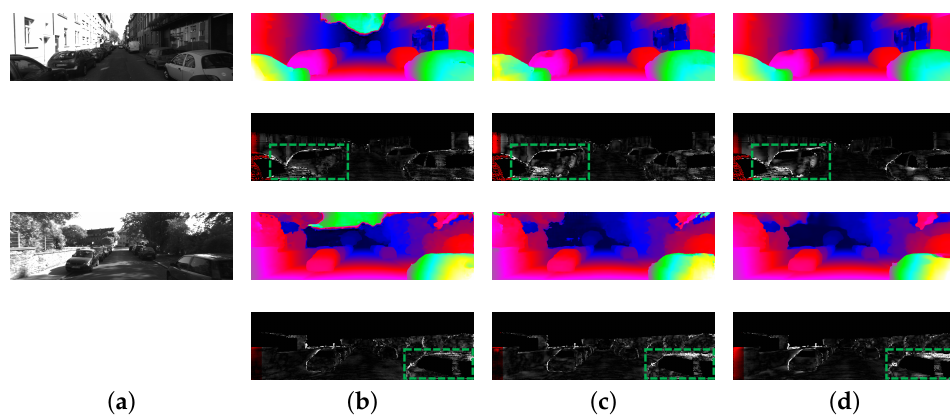
Figure 4. Results of disparity estimation for KITTI 2012 test images. We select the classic 3D stereo method PSMNet and recent proposed fast method AANet for comparison. We use the standard color scheme to represent the error and disparity maps. ( a ) Left Image. ( b ) JDCNet. ( c ) PSMNet. ( d ) AANet.